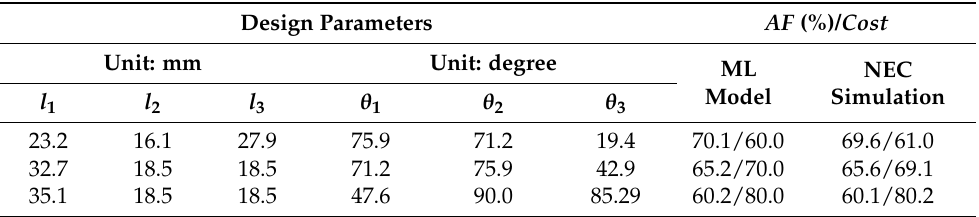
Table 5. Design parameters of the ranked antenna models in terms of AF when searching antenna models on the entire